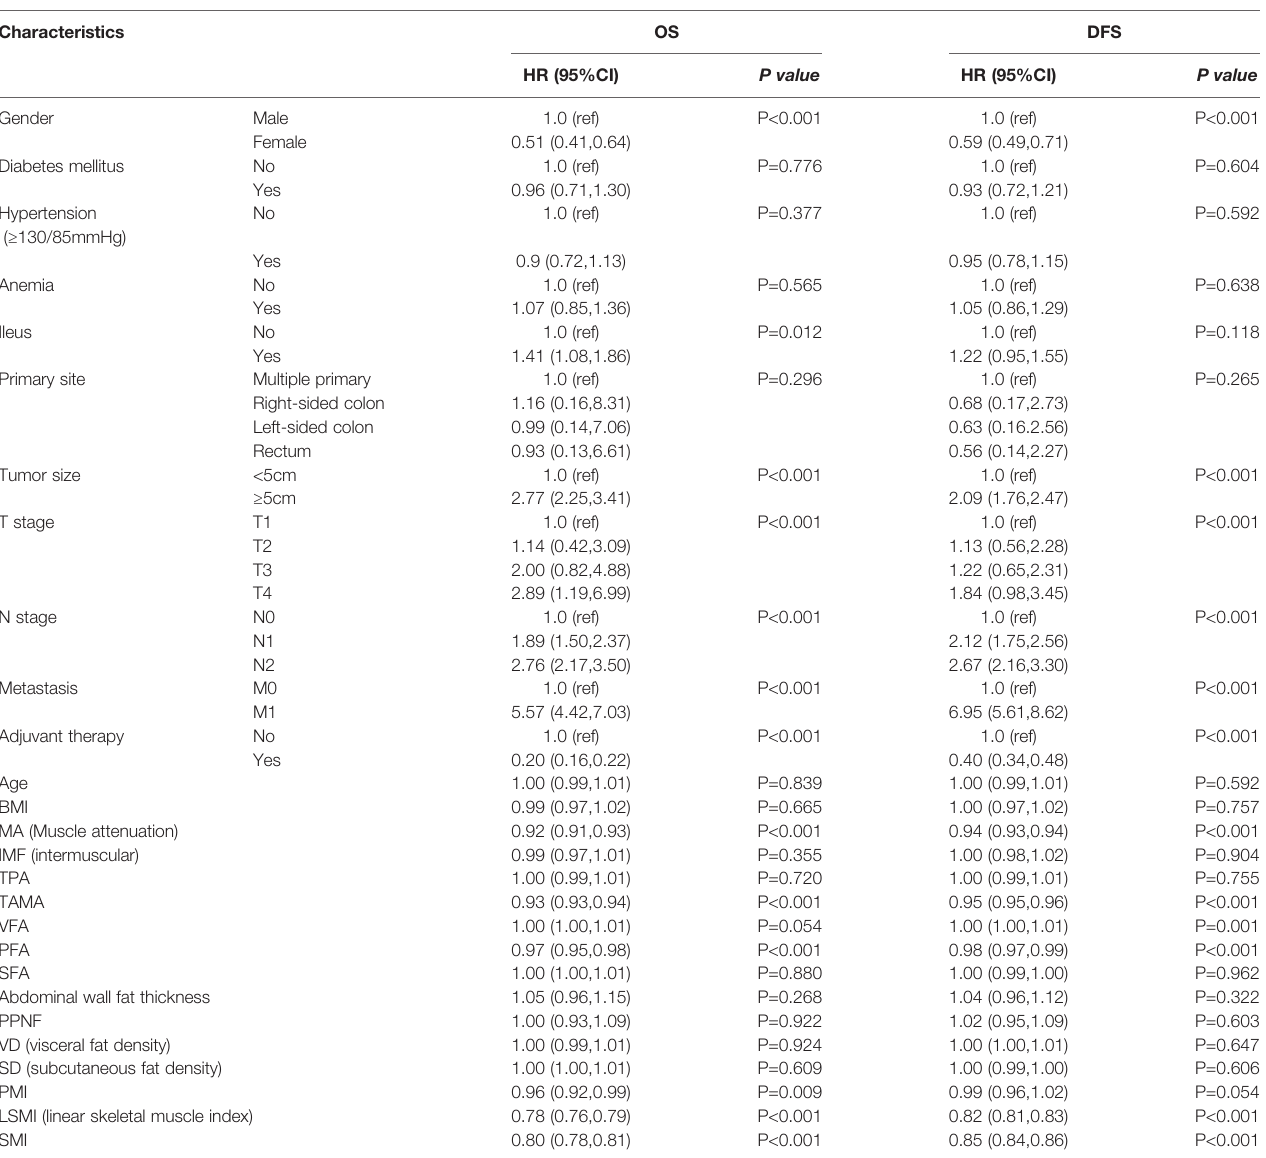
TABLE 2 | Univariate cox proportional hazard analysis for risk factors of patients ’ prognosis.